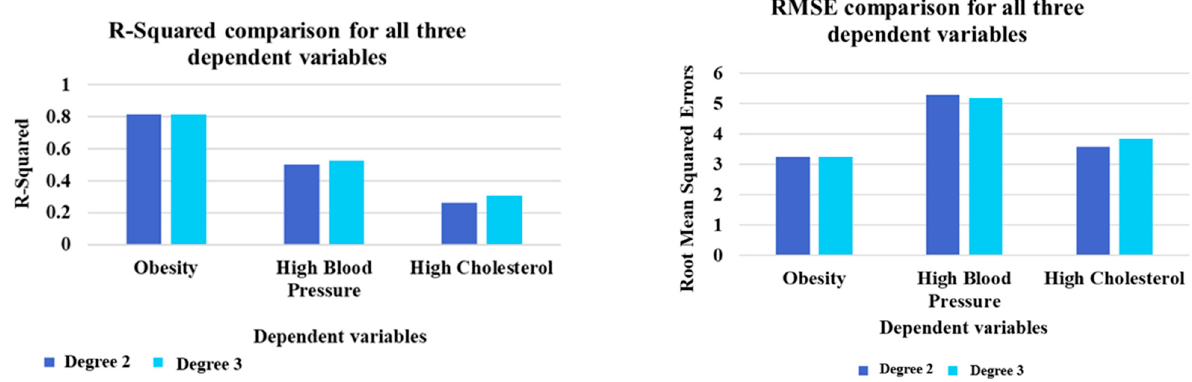
Figure 10. R-Squared and RMSE comparison of multivariate polynomial regression of second and third degrees.